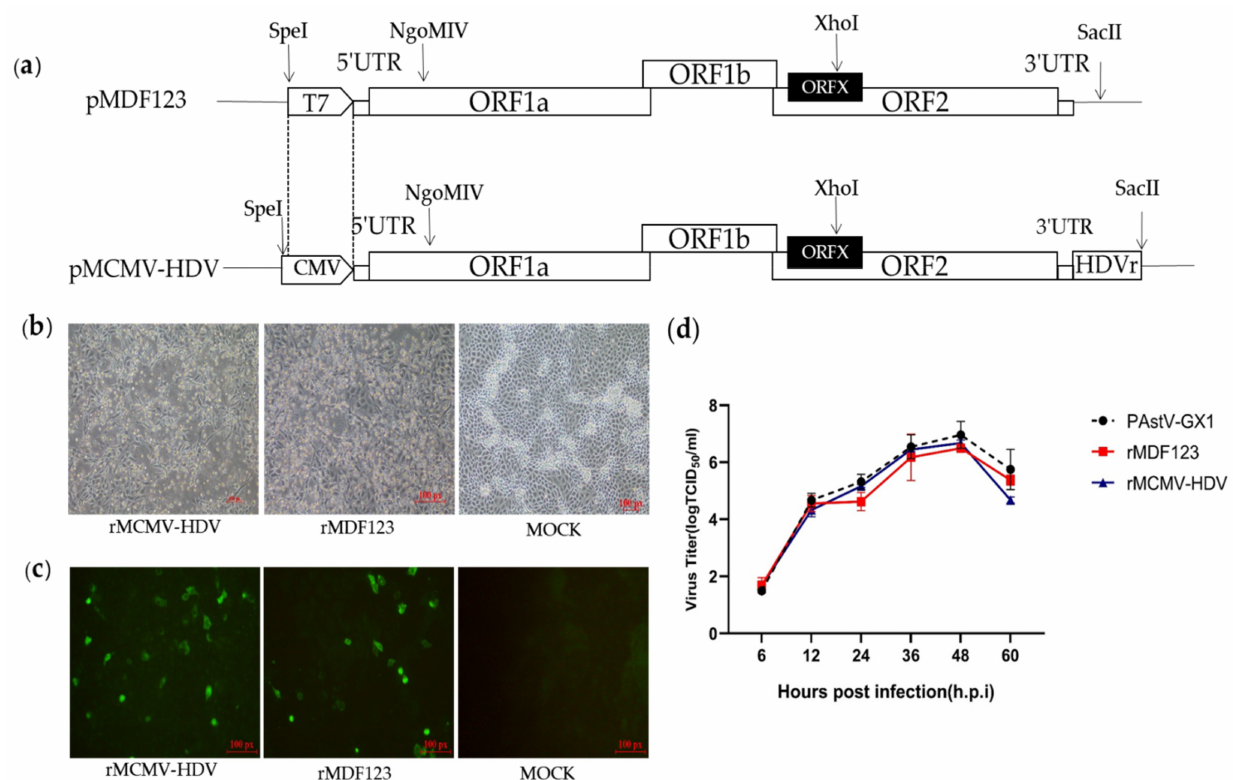
Figure 1. ( a ) Strategy for the construction of a full-length DNA-launched infectious clone of PAstV. The T7 promoter of pMD123 was replaced with a cytomegalovirus (CMV) promotor using SpeI and NgoMIV . The hepatitis delta virus ribozyme was inserted into the 3 (cid:48) terminal end of the PAstV-GX1 genome with XhoI and SacII. The restriction enzyme sites above the full-length cDNA clones are indicated by arrows. ( b ) Cytopathic effects were observed in PK-15 cells infected with rescued viruses (magnification 10 × ). ( c ) IFA analysis of the Cap protein expression in PK-15 cells. PK-15 cells infected with rescued and parental viruses were fixed at approximately 48 h.p.i and subjected to immunofluorescence using a polyclonal antibody against capsid protein. The PK-15 cells were stained with goat anti-mouse IgG H&L (CoraLite488) (magnification 20 × ). ( d ) Growth curves of the recombinant and parental viruses. PK-15 cells were infected with recovered and parental viruses at a multiplicity of infection of 0.01. The viral titers were determined as TCID 50